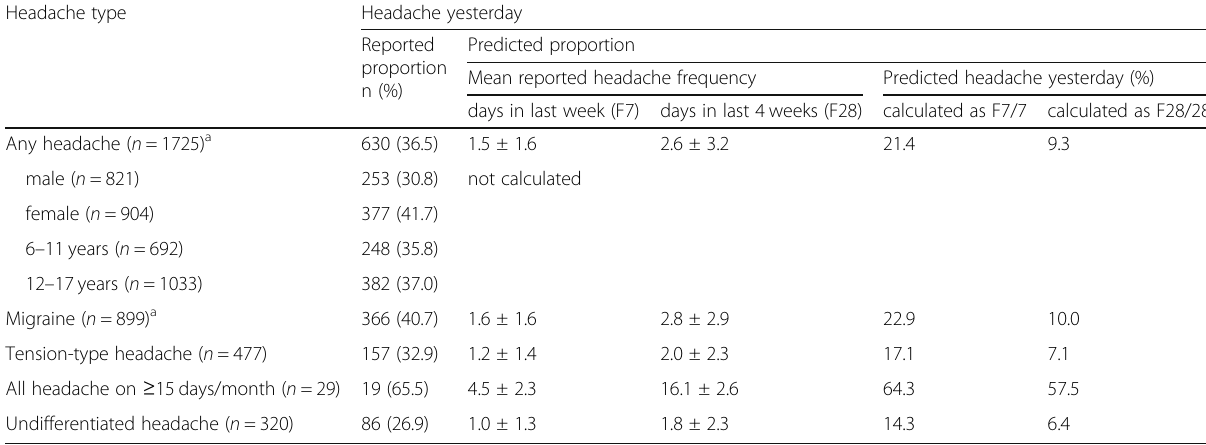
Table 6 Proportions of those with headache reporting headache yesterday, overall and by age, gender and headache type, and predicted proportions, overall and by headache